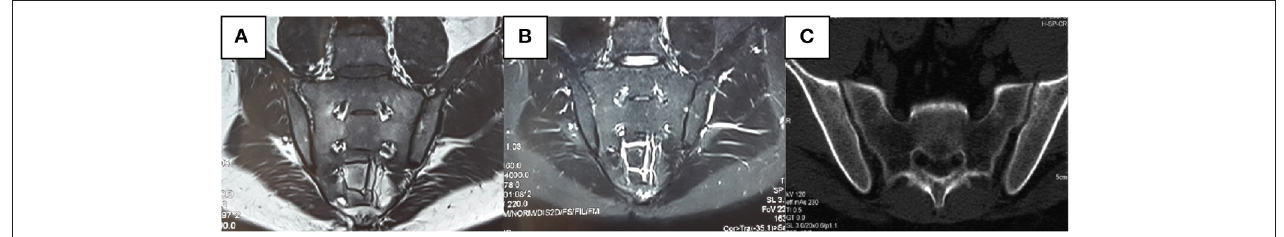
FIGURE 3 | Male, 31 years old, bilateral hip pain for 8 months and lumbago for 2 months. C-reactive protein, rheumatoid factors, and human leukocyte antigen-B27 were all negative. Alkaline phosphatase was 346 U/L. Inorganic phosphorus was 0.48 mmol/L. No apparent abnormalities were observed in the sacroiliac joint (SIJ)–magnetic resonance imaging T1-weighted [T1W, (A) ] and short-tau inversion recovery [STIR, (B) ] sequences. It can be seen in the computerized tomography that the left SIJ is coarse rather than smooth (C)